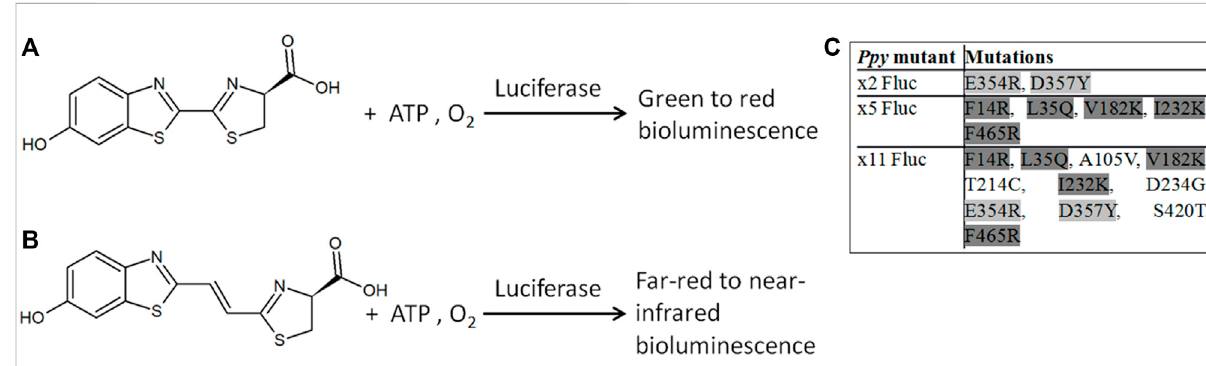
FIGURE 1 Bioluminescence reactions of beetle luciferases. Bioluminescence with D -LH 2 (A) and D -iLH 2 (B) (4S)-2-[(E)-2-(6-hydroxy-1,3-benzothiazol- 2-yl)ethenyl]-4,5-dihydro-1,3-thiazole-4-carboxylic acid; ATP: adenosine triphosphate. (C) Inset table of different subsets of mutations in thermostable mutants of Ppy Fluc: x2 Fluc (Willey et al., 2001), x5 Fluc (Law et al., 2006), and x11 Fluc (Jathoul et al.,